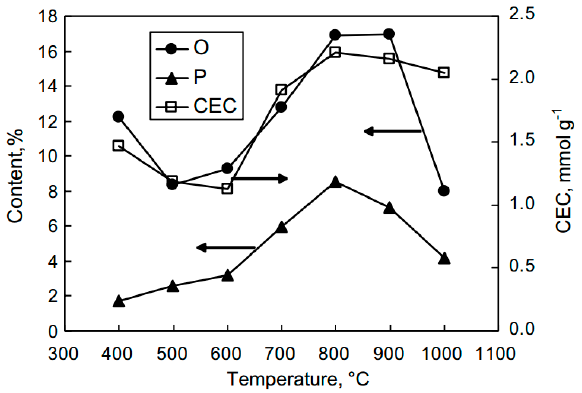
Figure 13. Phosphorous and oxygen contents together with cation exchange capacity (CEC) of H 3 PO 4 ACs as a function of heat treatment temperature. Reproduced from [78] with permission from Elsevier © 2005.